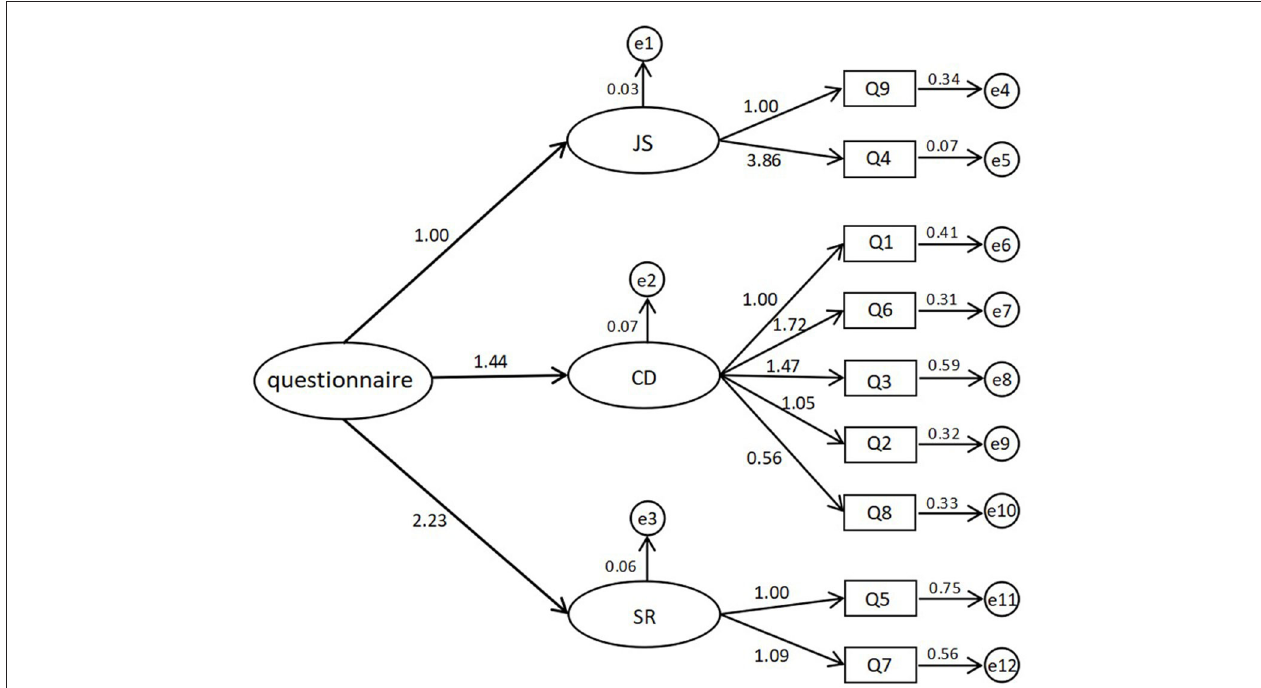
FIGURE 1 | The confirmatory factors analysis (CFA) of the